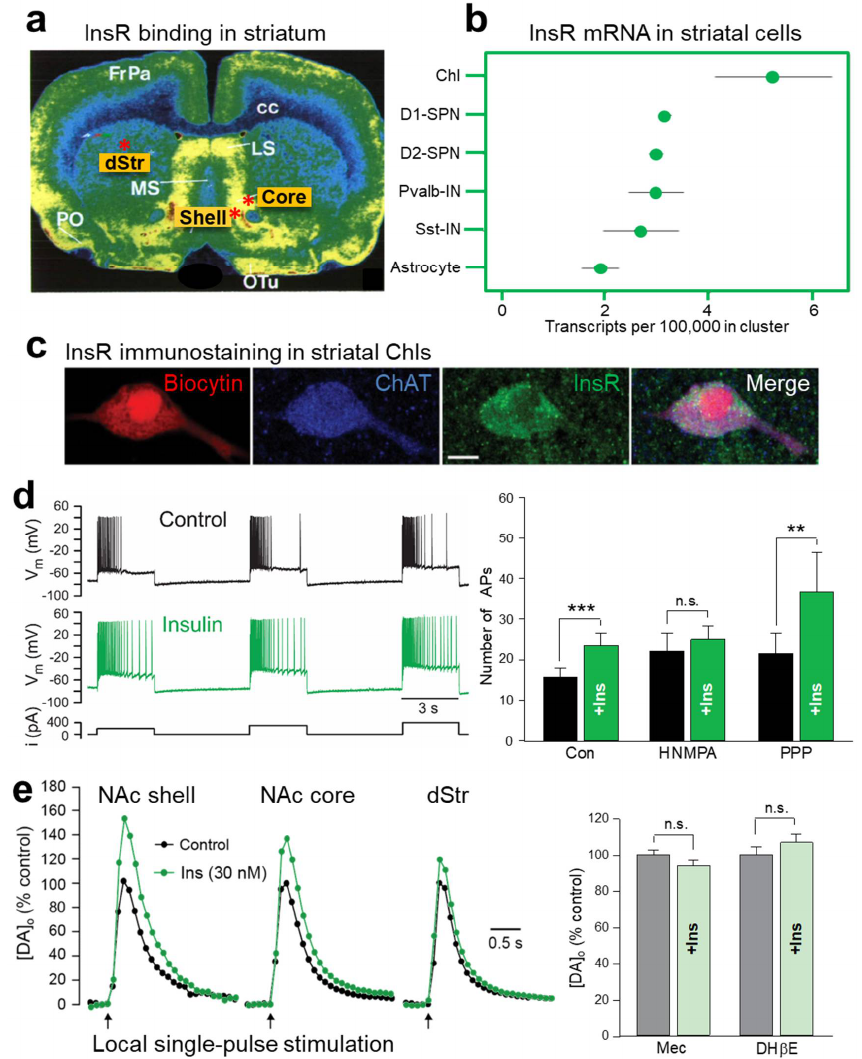
Figure 1. InsR localization in striatum and insulin-dependent regulation of striatal dopamine release via ChIs, InsRs and nAChRs. ( a ) Autoradiographic image of insulin receptor (InsR) binding sites throughout the rat striatum, including in the dorsal striatum (dStr), nucleus accumbens (NAc) core and shell subregions marked by red asterisks; modified with permission from [16]. Abbreviations: cc, corpus callosum; FrPa, frontal parietal cortex; LS, lateral septum; MS, medial septum; PO, preoptic area; oTu, olfactory tubercle. ( b ) Comparison of relative mRNA levels for InsRs in striatal cells shows high abundance in cholinergic interneurons (ChIs) versus D1 or D2 spiny projection neurons (SPNs), parvalbumin positive interneurons (Pvalb-IN), somatostatin positive interneurons (Sst-IN) or astrocytes; RNA-seq data was obtained using DropViz. ( c ) Immunohistochemical staining of InsRs in a biocytin-filled, ChAT-positive ChI; scale = 10 µ m; images from [19]. ( d ) Left: Response of current-clamped rat ChI to depolarizing current pulses; insulin (30 nM) increases ChI excitability by attenuating action potential (AP) accommodation. Right: Insulin-induced increase in ChI excitability is prevented by an InsR antagonist, HNMPA, but not by an IGF-1R antagonist, PPP; from [19]. ( e ) Left: Insulin (30 nM) enhances single-pulse evoked increases in extracellular dopamine concentration ([DA] o ) in dStr but has a greater effect in NAc core and NAc shell subregions of rat striatal slices. Right: Insulin evoked increases in [DA] o are prevented by nAChR antagonists, mecamylamine (mec) or DH β E; from [19]. For d and e, n.s. is not significant, ** p < 0.01, *** p <